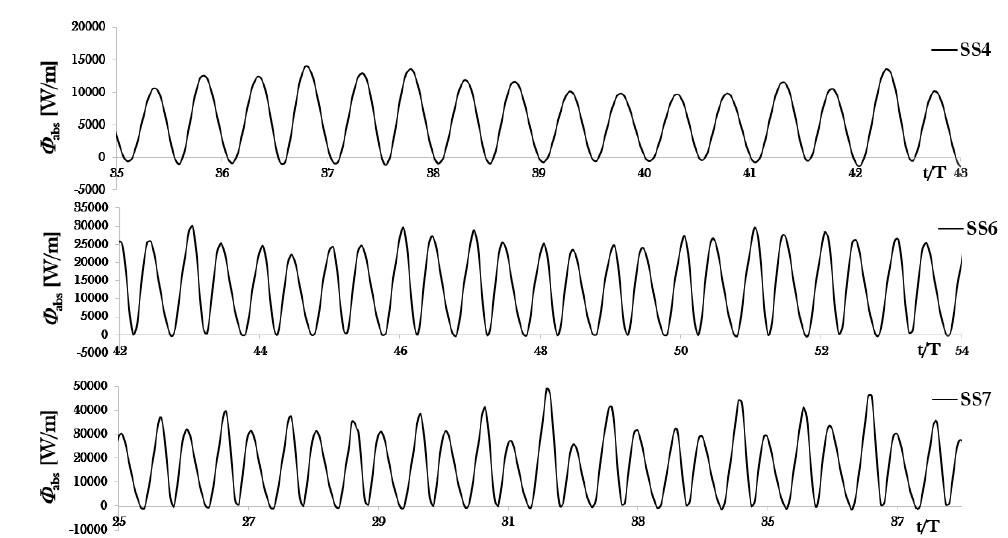
Figure 15. Time histories of the energy fluxes absorbed by the plant in the three different wave